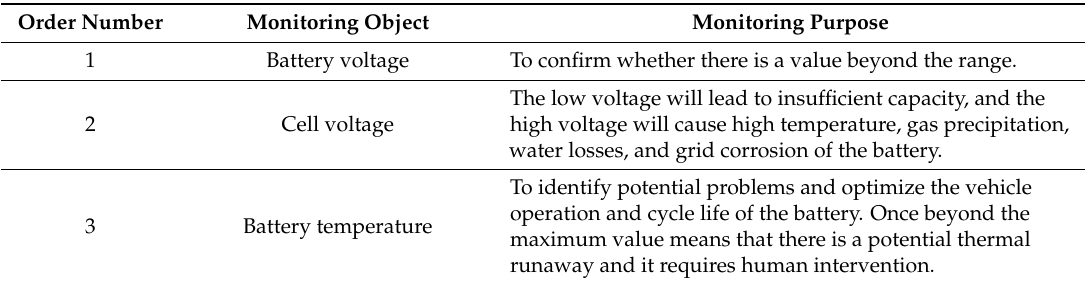
Table 1. The main monitoring objects and purposes of NSMC-EV.